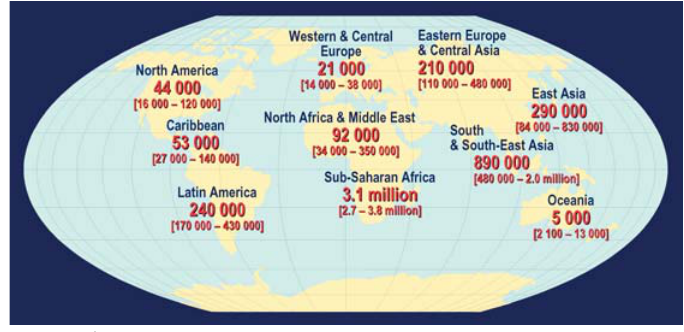
Figure 2. Estimated Number of Adults and Children Newly Infected with HIV during 2004 (Total: 4.9 [4.3–6.4] million) (Map: UNAIDS/WHO)